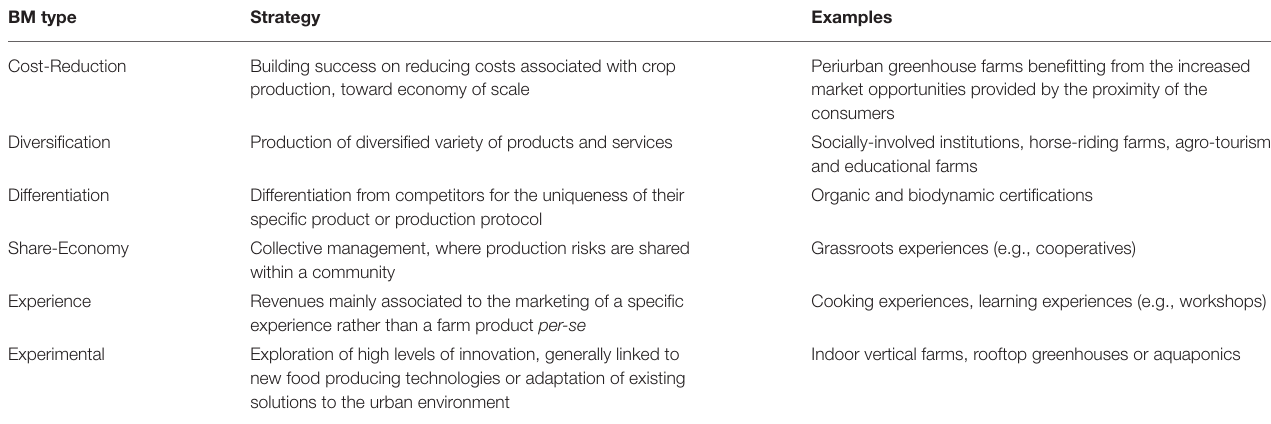
TABLE 5 | Main business models associate with UA systems in the Global